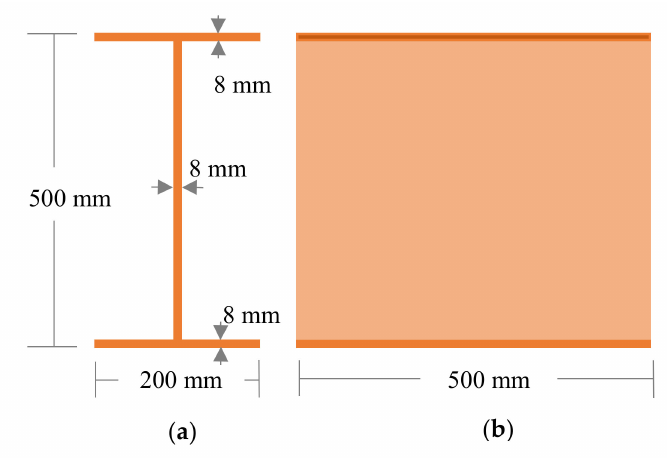
Figure 3. The steel beam dimensions: ( a ) Section; ( b ) Side view.